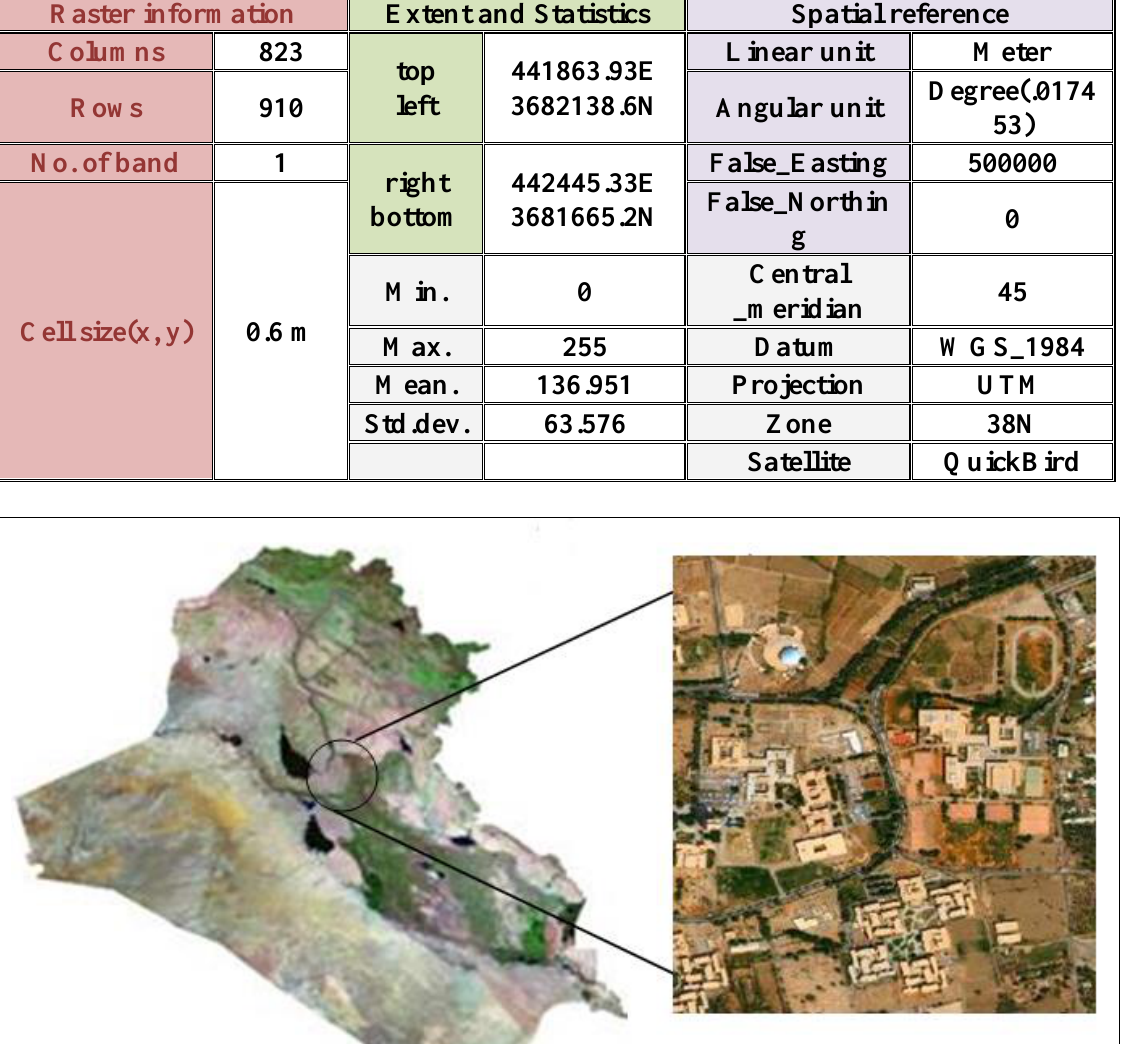
Table 1: Represent the studied area information.